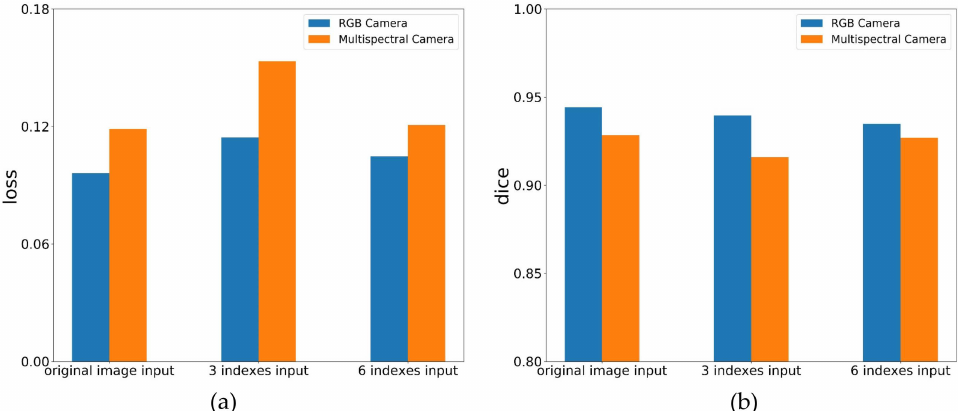
Figure 11. Comparison of di ff erent sensor applications: ( a ) loss comparison of di ff erent sensor applications; ( b ) dice comparison of di ff erent sensor